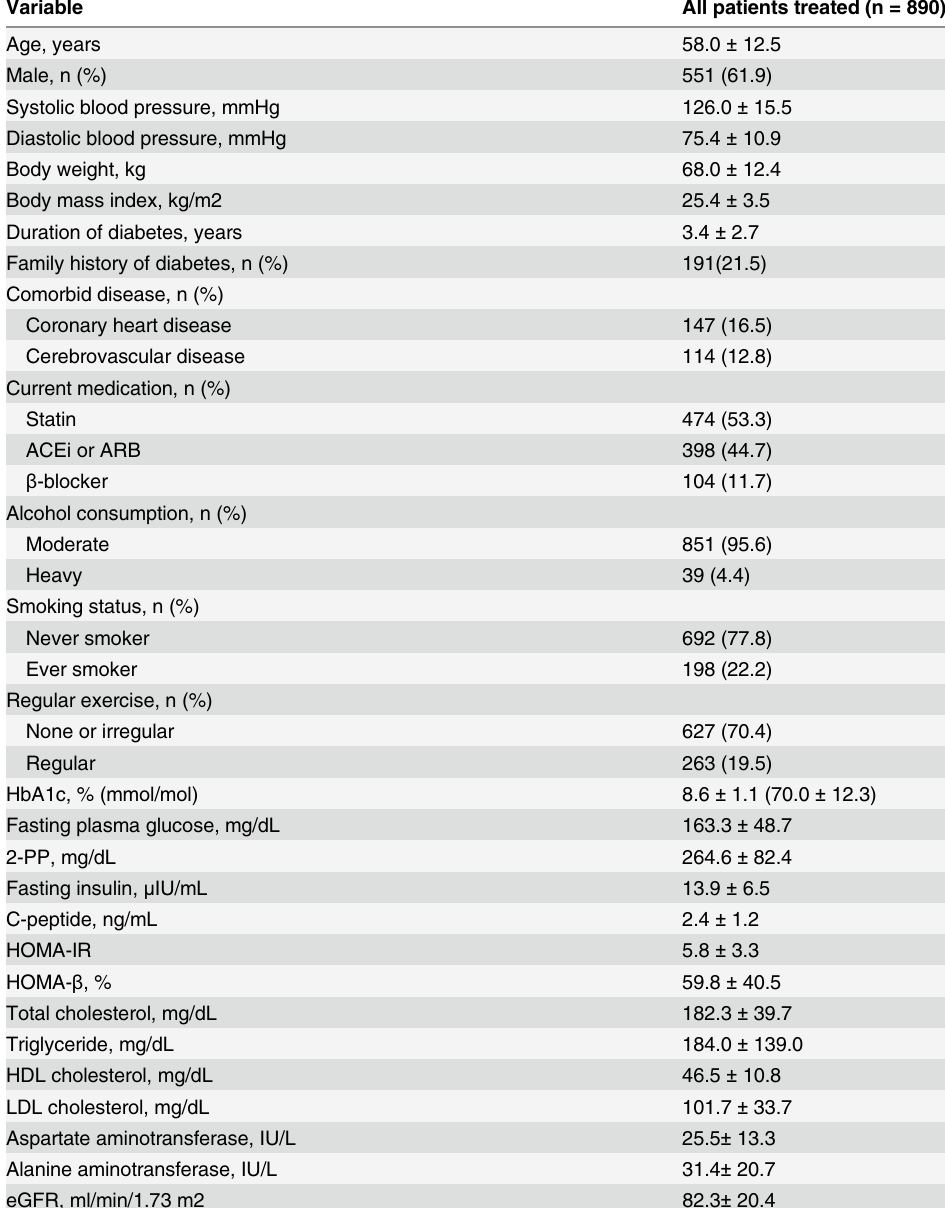
Table 1. Baseline demographic and laboratory data for study